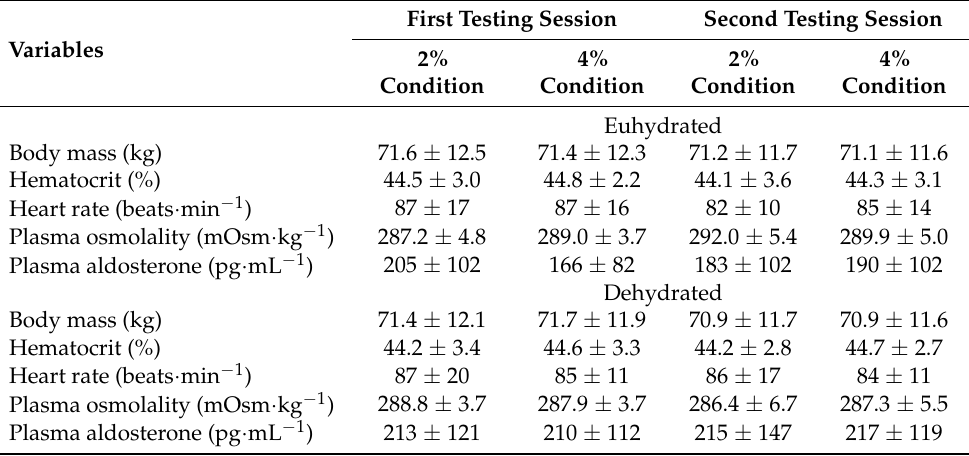
Table 2. Hydration state prior to each testing session with euhydration and